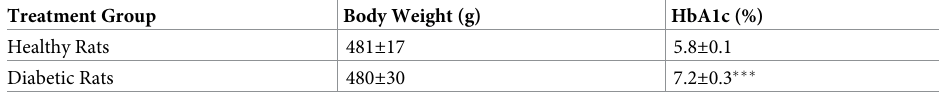
Table 3. Body weight and HbA1c levels of healthy and diabetic rats. Treatment Group Body Weight (g) HbA1c (%) Healthy Rats 481 ± 17 5.8 ± 0.1 Diabetic Rats 480 ± 30 7.2 ± 0.3 ��� Body weight of diabetic and healthy rats were measured (n = 5). Tail blood was collected in a tube containing EDTA and stored at 4˚C. Glycated hemoglobin A1c (HbA1c) was determined using a rat HbA1c kit (Crystal Chem), following the manufacturer’s